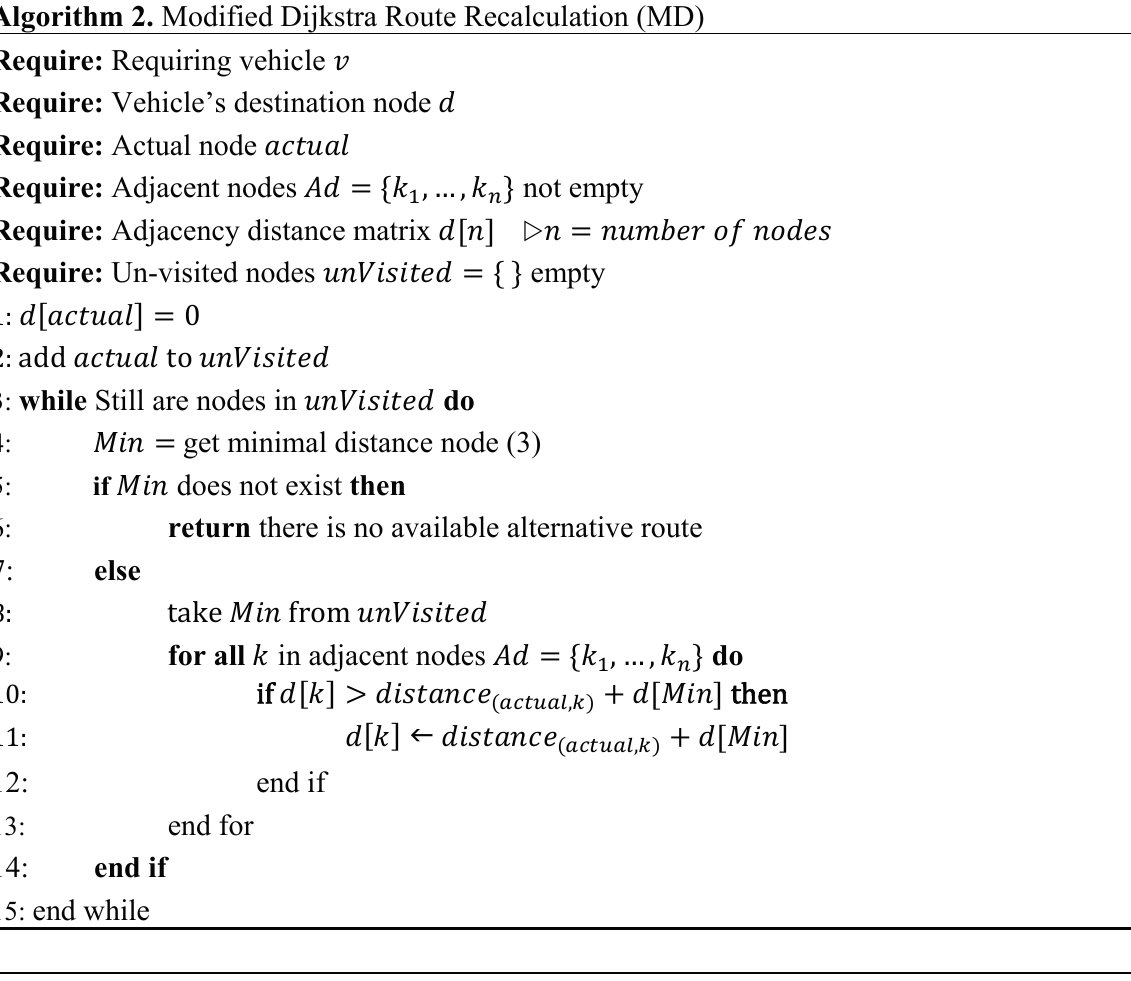
Algorithm 3. Get minimal distance